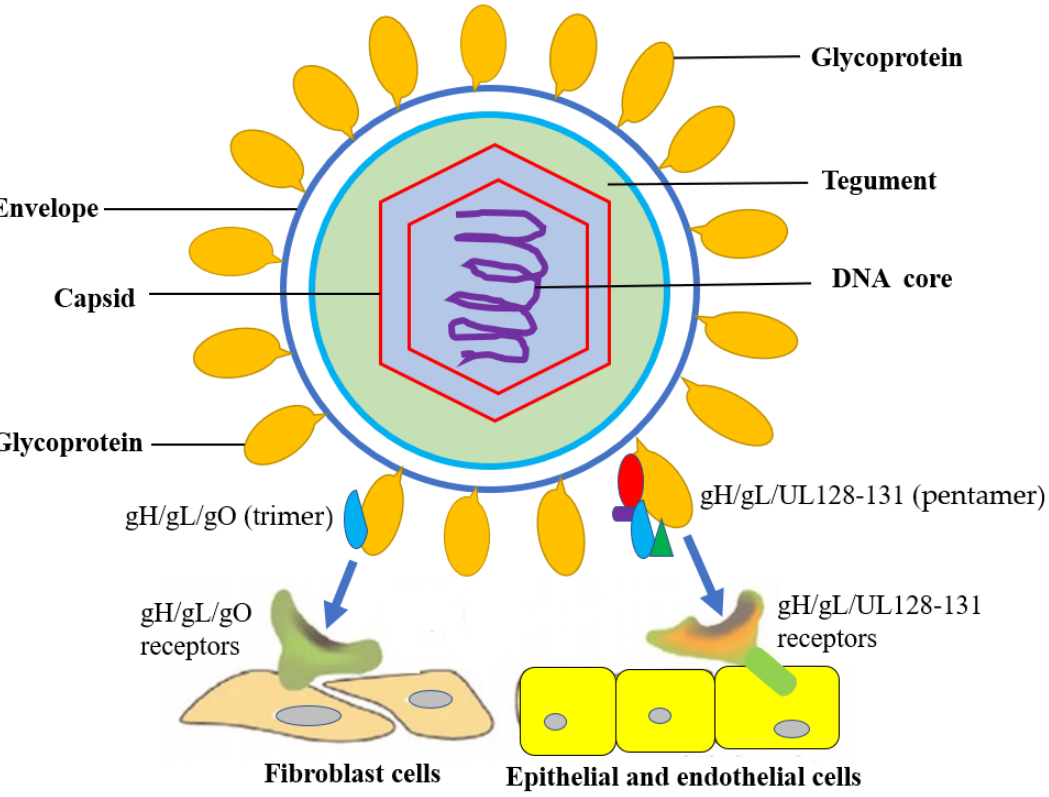
Figure 1. HCMV structure and entry into host cells. HCMV glycoproteins gH, gL, UL128, UL130 and UL131 assemble together to form a functional complex for binding to host cellular receptors, such as gH/gL/UL128- 131 receptors and gH/gL/gO receptors. gH/gL/UL128-131 mediates entry into epithelial/endothelial cells and gH/gL/gO mediates entry into fibroblasts.